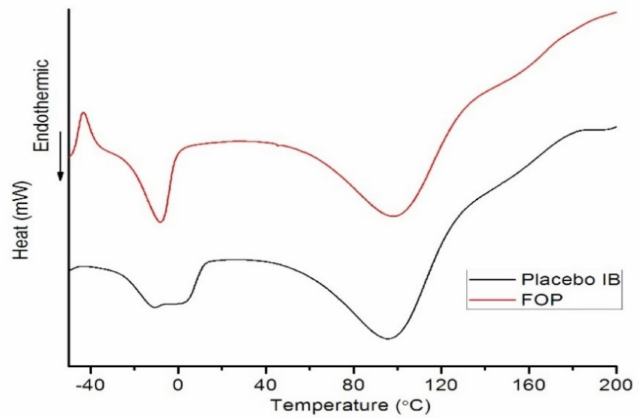
Figure 9. Di ff erential scanning calorimetry (DSC) curves of placebo and optimal printlet.